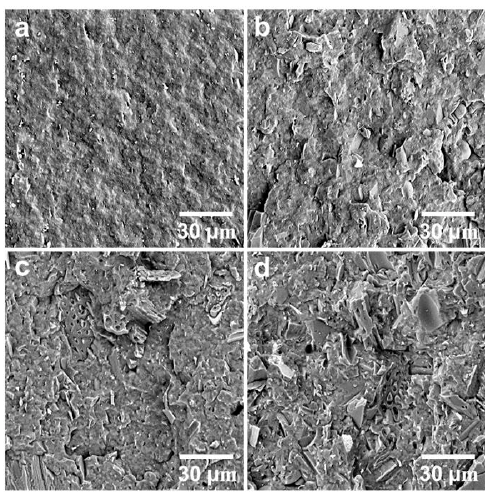
Figure 4. SEM images of the fracture surfaces of ( a ) PHBV, ( b ) PHBV / MB10, ( c ) PHBV / MB20, and ( d ) PHBV / MB30 composites.